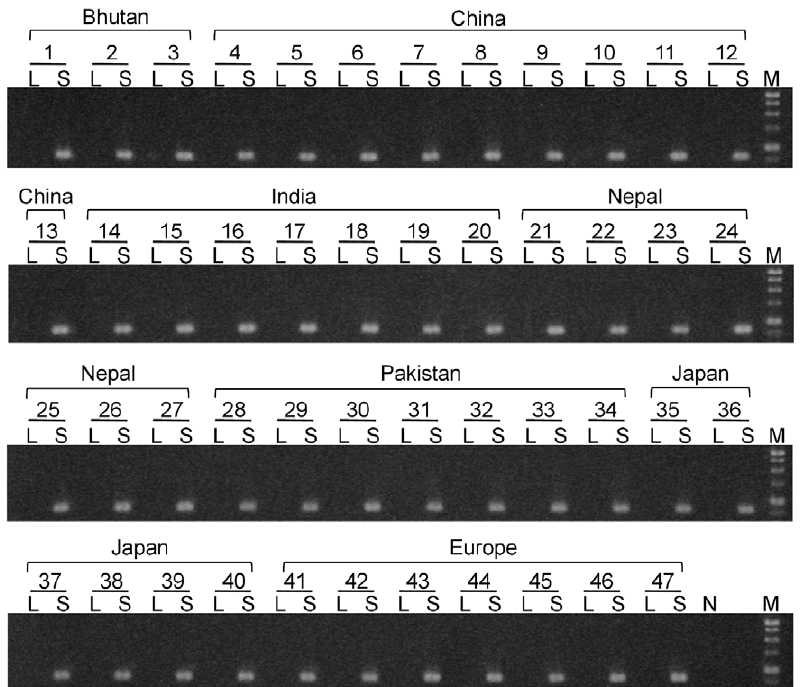
Figure 4. PCR survey of S-ELF3 ( SSG3 ) in 47 buckwheat landraces and modern cultivars. The numbering of individual plants corresponds to that shown in Table S2. L, long-styled plant. S, short-styled plant. N, negative control. M, 1-kb DNA ladder (GenDireX).